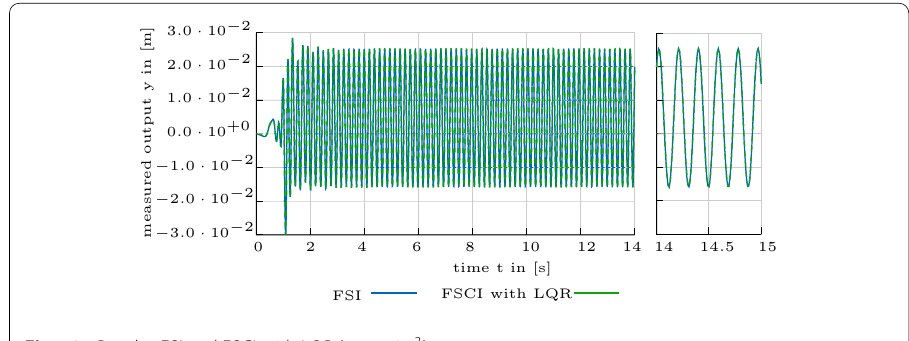
Fig. 13 Results: FSI and FSCI with LQR ( γ = 10 − 3 )